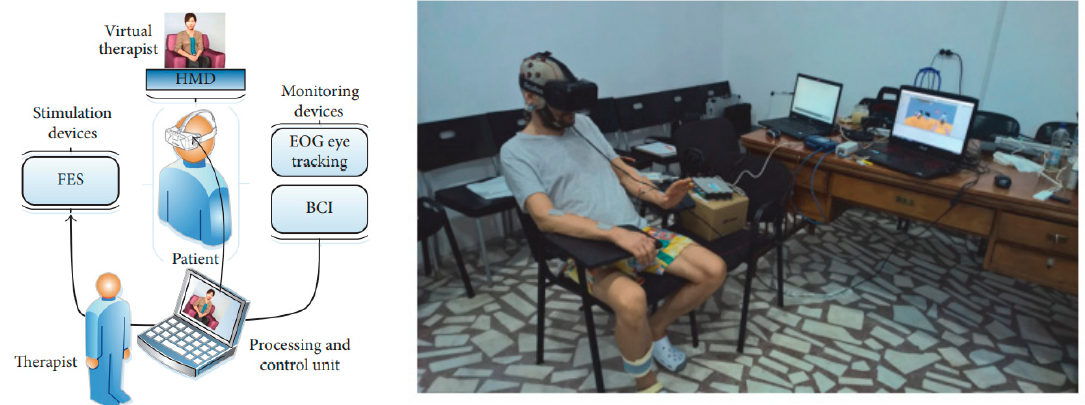
Figure 14. BCI-FES subsystem and the patient executing the control command for a rehabilitation exercise [105].